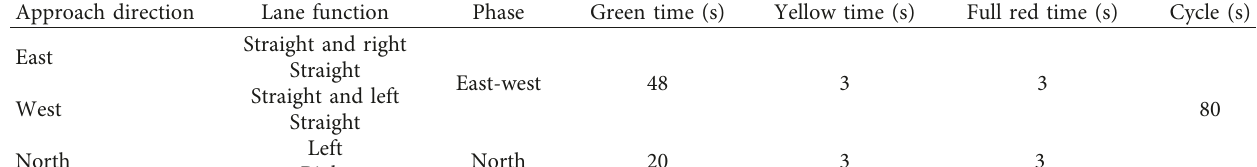
Figure 7: The traffic conflict probability and conflict distribution of intersection under nonsignalized strategy. (a) The heat map of traffic conflict probability. (b) Traffic conflict distribution in an hour. Table 5: The signal timing parameters based on the Webster method.